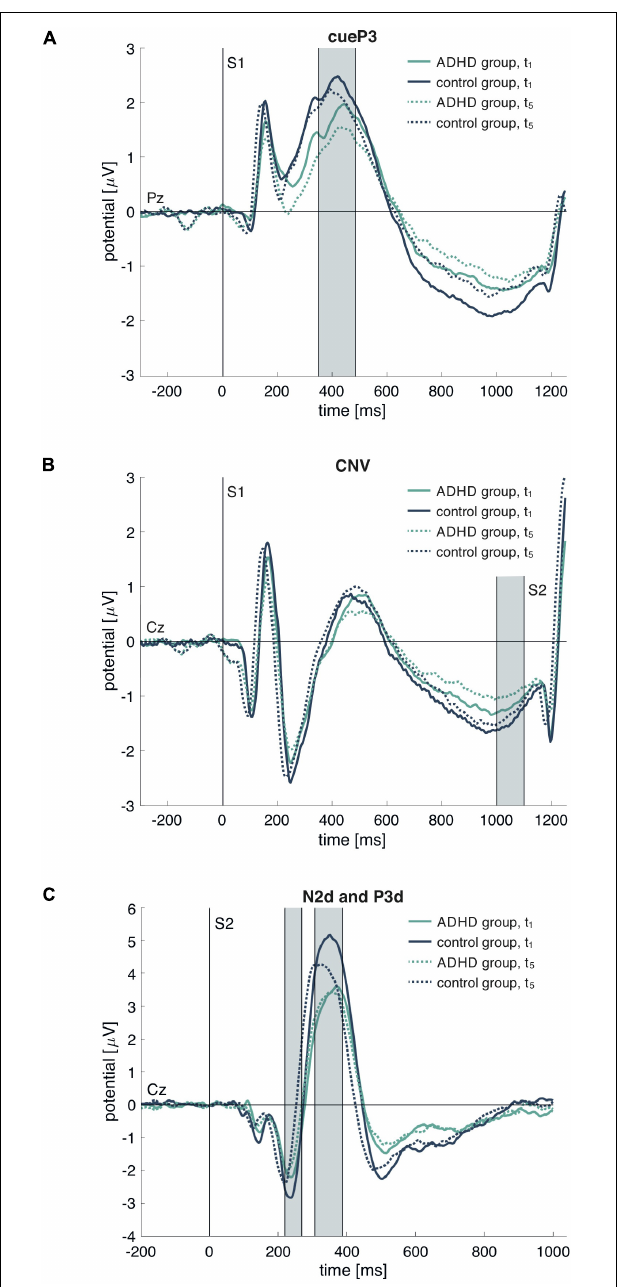
FIGURE 1 | Grand average event-related potential (ERP) waves for the attention-deficit/hyperactivity disorder (ADHD) and control group in (A) all cue conditions (A–A or A–P) for cueP3 on Pz, (B) all cue conditions (A–A or A–P) for CNZ on Cz and (C) the difference curve between NoGo (A–P) and Go (A–A) after S2 for N2d and P3d. Displayed are the curves for the first (t 1 ) and last (t 5 ) assessment. The gray bars indicate analyzed time windows for the ERP extraction. S1 marks the cue stimulus and S2 the target